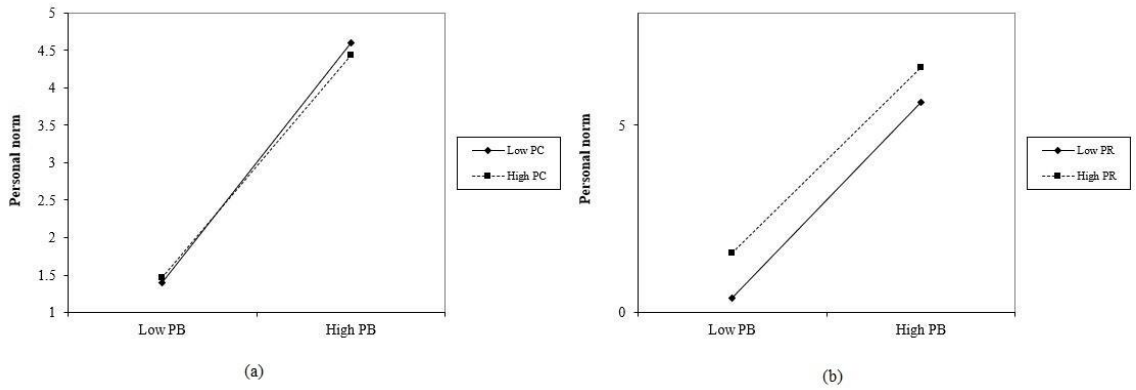
Figure 4. Interacting effects between PB and PC ( a ) and PB and PR ( b ). First, there is no significant interaction between PV and PN. The result indicates